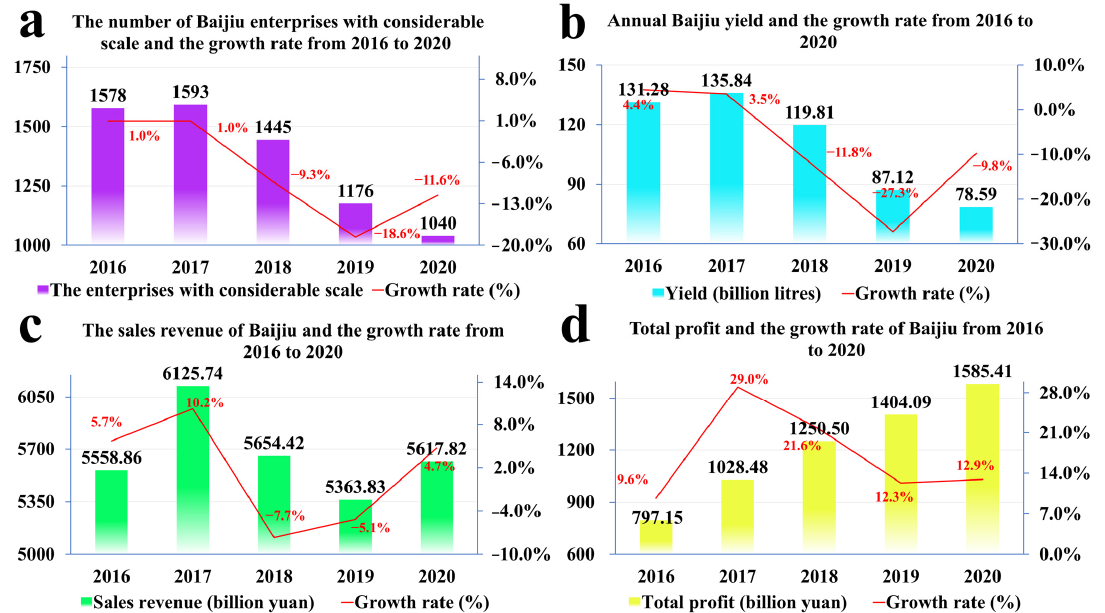
Figure 1. Overview of the Baijiu industry from 2016 to 2020.